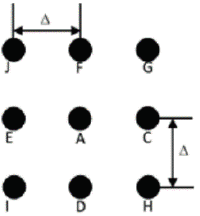
Figure 3. One plane of the